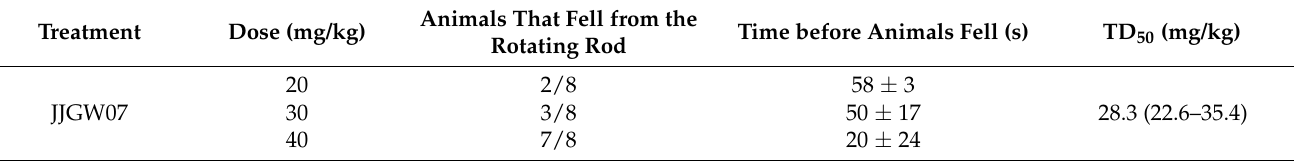
Table 3. The effect of JJGW07 on the motor coordination in